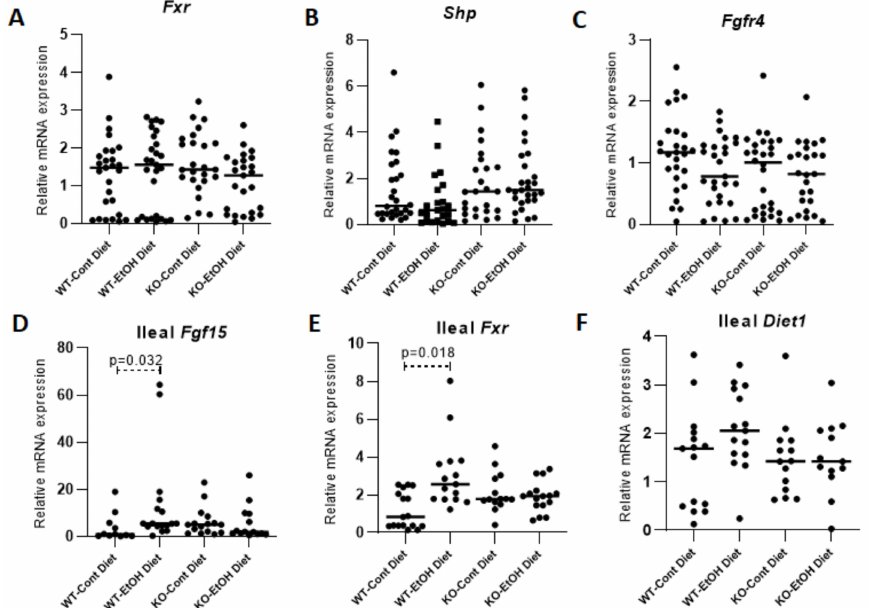
Figure 4. Relative quantification of mRNA levels of hepatic and ileal genes that play a role in transcriptional regulation of Cyp7a1 . Transcriptional levels of Fxr ( A ), Shp ( B ), and Fgfr4 ( C ) in the liver ( n = 28 per group), and Fgf15 ( D ), Fxr ( E ), and Diet1 ( F ) in the ileum were determined ( n = 15 per group). Cont, control diet; EtOH, ethanol diet; KO, Abcb4 knockout mice; WT, C57BL/6J wild-type mice. p < 0.05 was considered